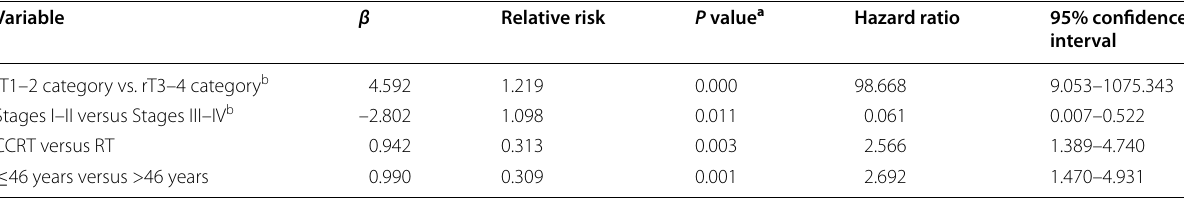
Abbreviations as in Tables 1 and 2 a By Cox proportional hazards model test